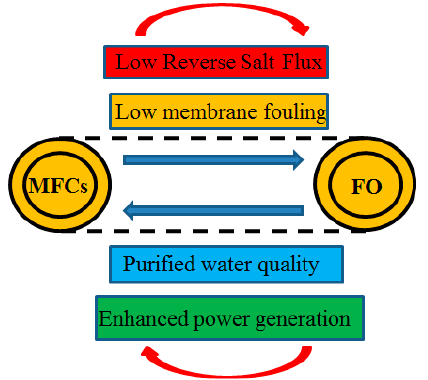
Figure 1. Coupling advantages of forward osmosis technology and microbial fuel cells.